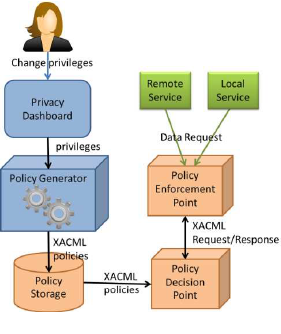
Figure 6: Privacy